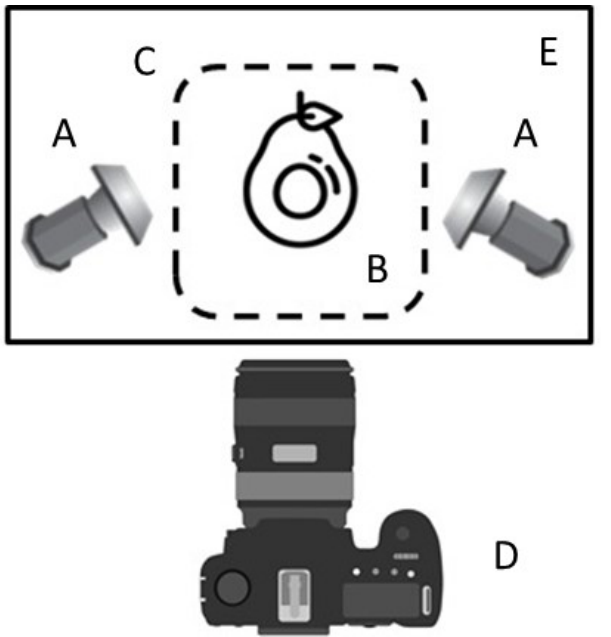
Figure 3. Diagram of the photographic set used to monitor fruit in storage. ( A ) LED spotlight (17 W); ( B ) avocado cv. Hass; ( C ) photographic set; ( D ) camera, ( E ) support table. ( B ) avocado cv. Hass; ( C ) photographic set; ( D ) camera, ( E ) support